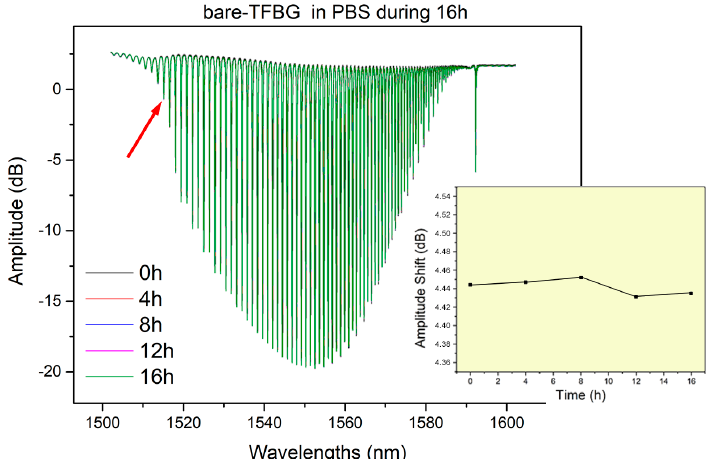
Figure 2. Graph showing bare tilted fiber Bragg gratings spectra after 4, 8, 12 and 16 h in PBS compared to initial measurement in same solution. The bio-responsive modes, which are tracked for biosensing and located near the cut-off wavelength are stable over time.